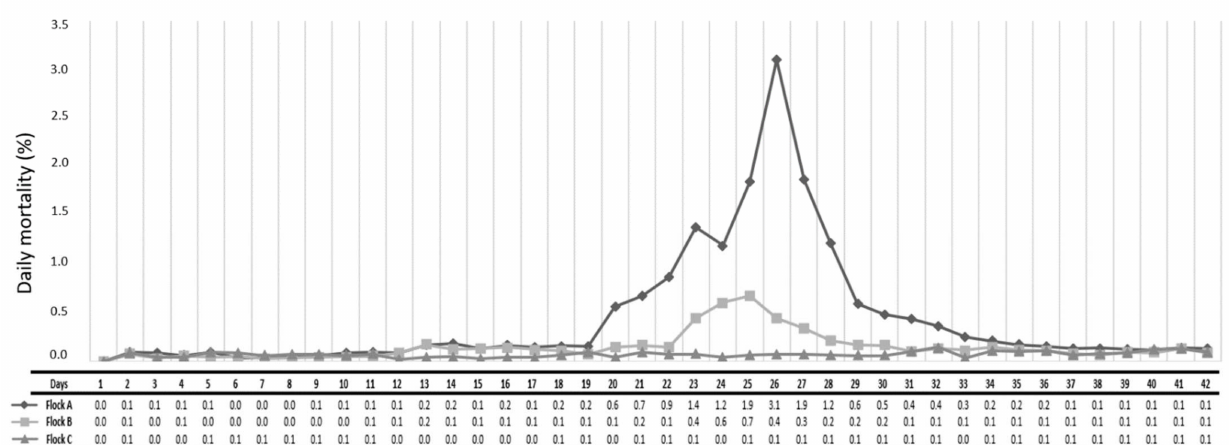
Figure 2. A curve of the daily mortality recorded in each of the three flocks (Flock A–C) of the farm over the rearing period. Daily measurements represent the number of dead birds divided by the population at